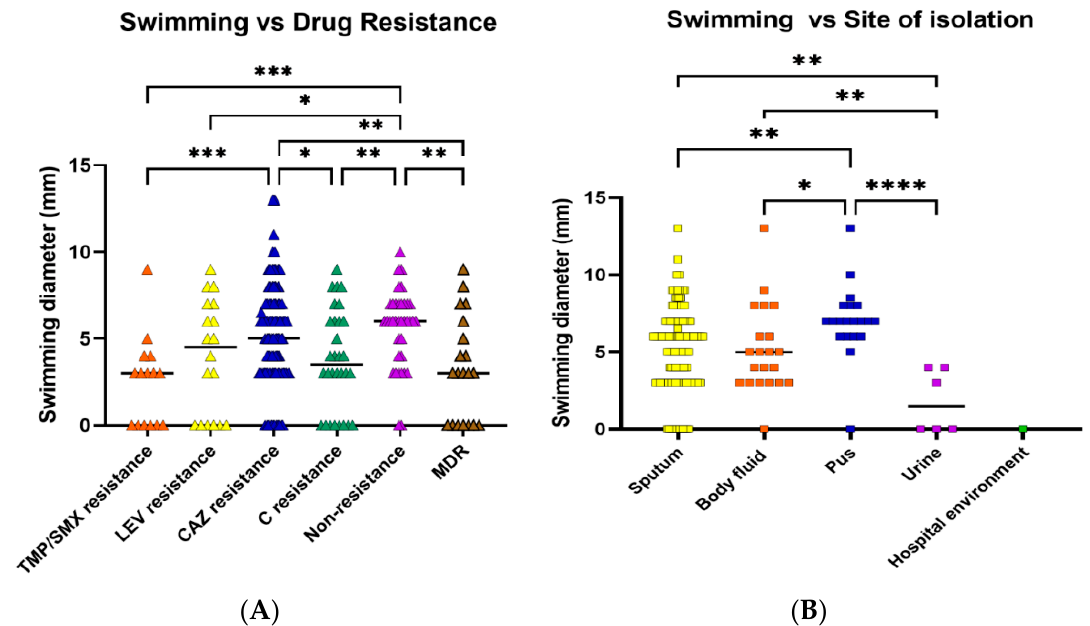
Figure 2. Swimming motility of S. maltophilia isolates. Swimming motility was evaluated by measuring the swimming zone diameter in a semi-solid medium (0.3% agar). Swimming efficacies were investigated in various antibiotic-resistant groups ( A ) and sites of isolation ( B ). Each symbol showed the mean swimming diameter with the median line of each distribution. A percentage of isolates belonged to each group. Statistical significance at Fisher’s exact test: * p < 0.05, ** p < 0.01, *** p < 0.001, **** p < 0 . 0001 .